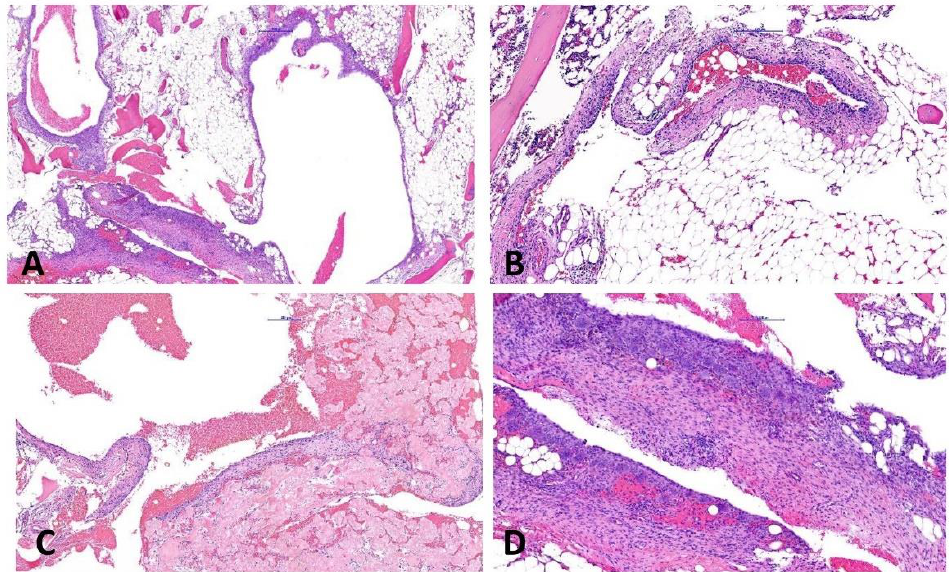
Figure 2. ( A , B ) The cystic tumor (case #1) has thin fibrous walls. ( C , D ) Unmineralized fibrin-like deposits of collagen are present along with plump, cytological bland, ovoid, and spindle cells with scattered osteoclast-like giant cells.